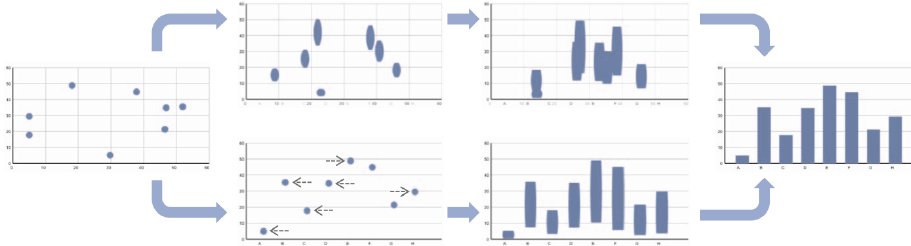
Figure 27. Heer and Robertson show the process of transition for a scatter plot to a bar chart. The top path starts by stretching the points to size and then moving to the right location, whereas the bottom path moves the dots first, then resizes and reshapes them [50]. Image courtesy of Heer and Robertson